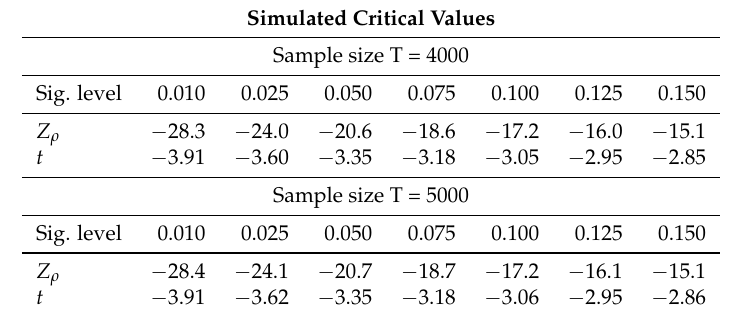
Table 3. Cointegration